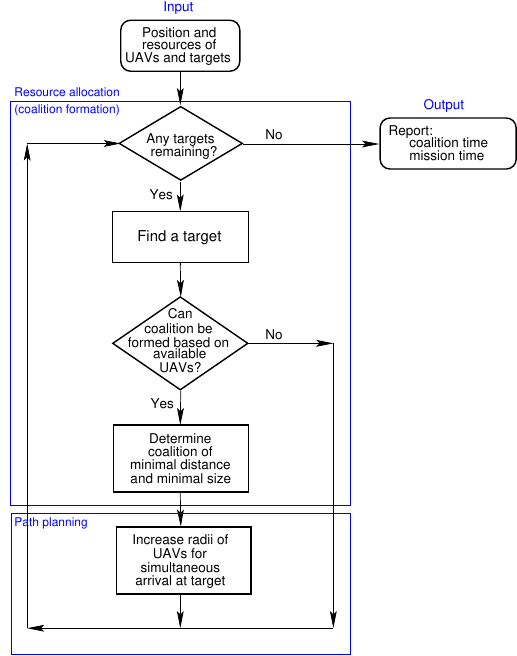
Figure 2. Diagram depicting solution